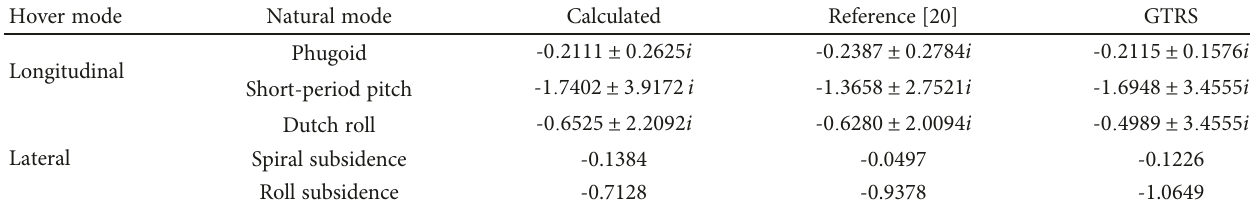
Table 3: Airplane mode V = 200kt eigenvalue validation.